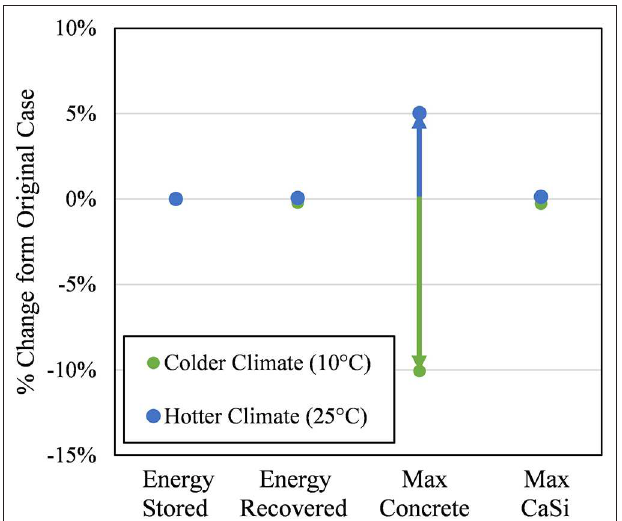
FIGURE 12 | Sensitivity of key results to colder (l0 ◦ C) and hotter (25 ◦ C) climates relative to their value from the original climate case (20 ◦ C). Energy stored refers to the quantity of thermal energy remaining in the particles at the end of the last storage cycle. Energy recovered refers to the quantity of thermal energy recovered by the particles at the end of the last recovery cycle. Max. Concrete and CaSi refer to the absolute maximum point temperature over the final cycle for the respective materials.